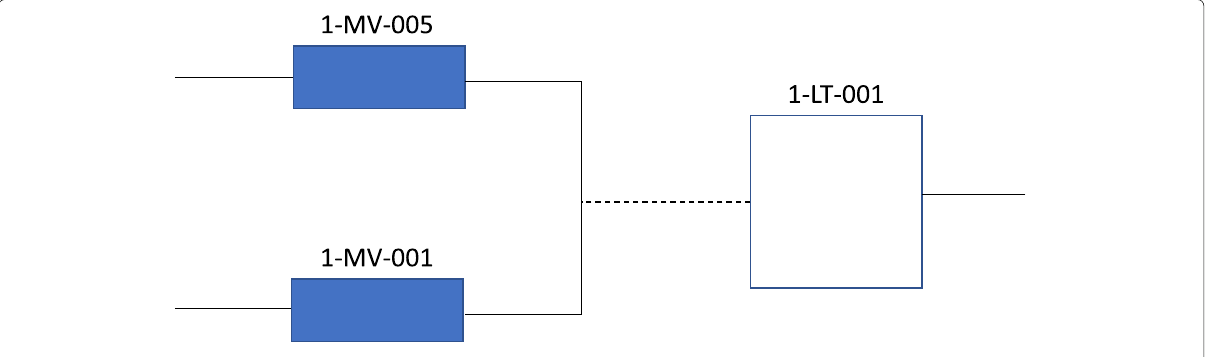
Fig. 12 Attack #10 on WADI: single attack, one stage